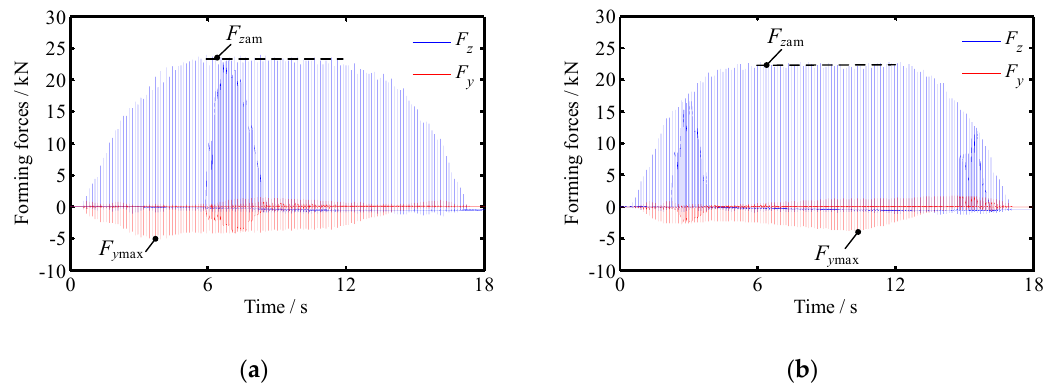
Figure 5. Forming forces of the CRBF forming process: ( a ) Up-beating; ( b ) down-beating.